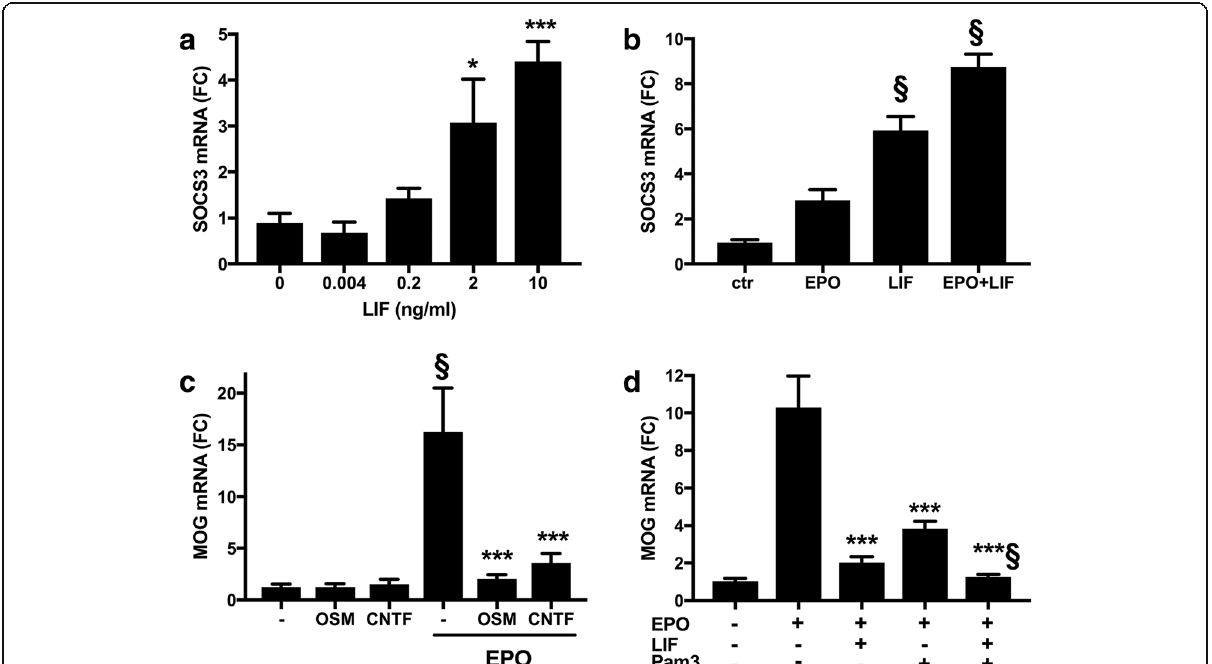
Fig. 4 Role of SOCS3 and TLR2 in mediating LIF inhibition. a-b LIF induction of SOCS3 is associated with a reduction in MOG expression (shown in Fig. 1). Cells cultured for 1 day in GM were switched to DM; after 3 h they were treated with the indicated concentrations of LIF ( a ), or with or without EPO (10 ng/ml) and LIF (10 ng/ml; b ). After 1 h, SOCS3 mRNA was measured by RT-qPCR. Results, expressed as fold change (FC) vs one of the control (ctr) samples (no LIF in a ) are the mean ± SD of quadruplicate samples assayed in duplicate and are representative of two independent experiments; * P < 0.05, *** P < 0.001 vs control (no LIF); § P < 0.001 vs EPO by two-tailed Student ’ s t- test. c OSM and CNTF inhibit EPO-induced MOG expression . Cells cultured as above were treated with or without EPO (10 ng/ml) and OSM or CNTF (both at 6.5 ng/ml, equimolar concentrations to LIF 10 ng/ml). MOG gene expression was measured by RT-qPCR at day 3. Results, expressed as above, are the mean ± SD of eight samples from two independent experiments assayed in duplicate; *** P < 0.001 vs EPO alone; § P < 0.001 vs untreated by two-tailed Student ’ s t- test. d TLR2 engagement inhibits EPO-induced MOG expression. Cells were differentiated in the absence or in the presence of EPO (10 ng/ml), with or without LIF (10 ng/ml) or Pam3 (1 μ g/ml), a TLR2/1 ligand. MOG expression was measured at day 3 by RT-qPCR. Results, expressed as above, are the mean ± SD of quadruplicate samples assayed in duplicate and are representative of two independent experiments; *** P < 0.001 vs EPO alone; § P < 0.01 vs EPO + LIF by two-tailed Student ’ s t-